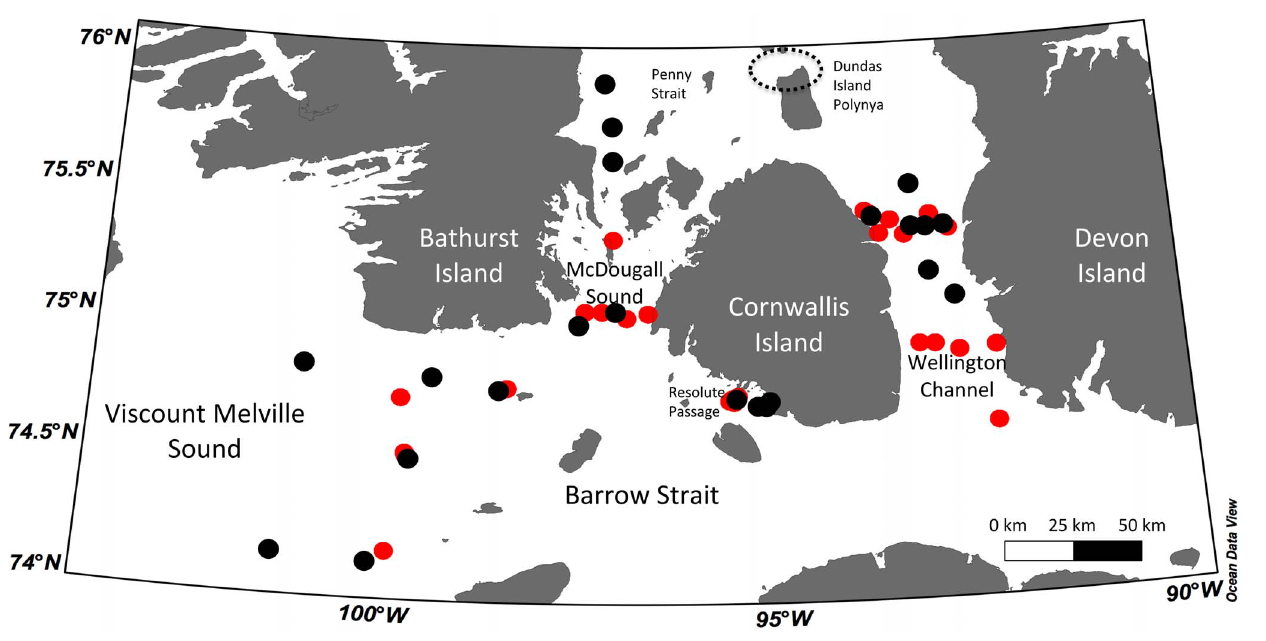
Figure 1. Stations sampled for ice algae and pelagic diatoms during May 2011 (black) and May 2012 (red) around Cornwallis Island, Nunavut. The dotted circle represents Dundas Island